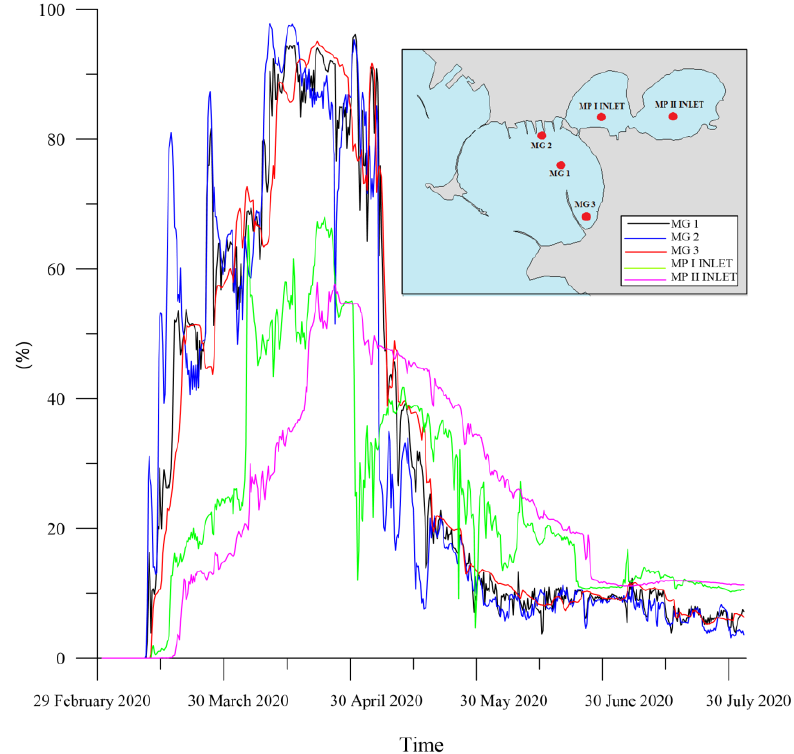
Figure 9. Percentage of heavy metal concentration reduction during the COVID-19 pandemic lock- down.